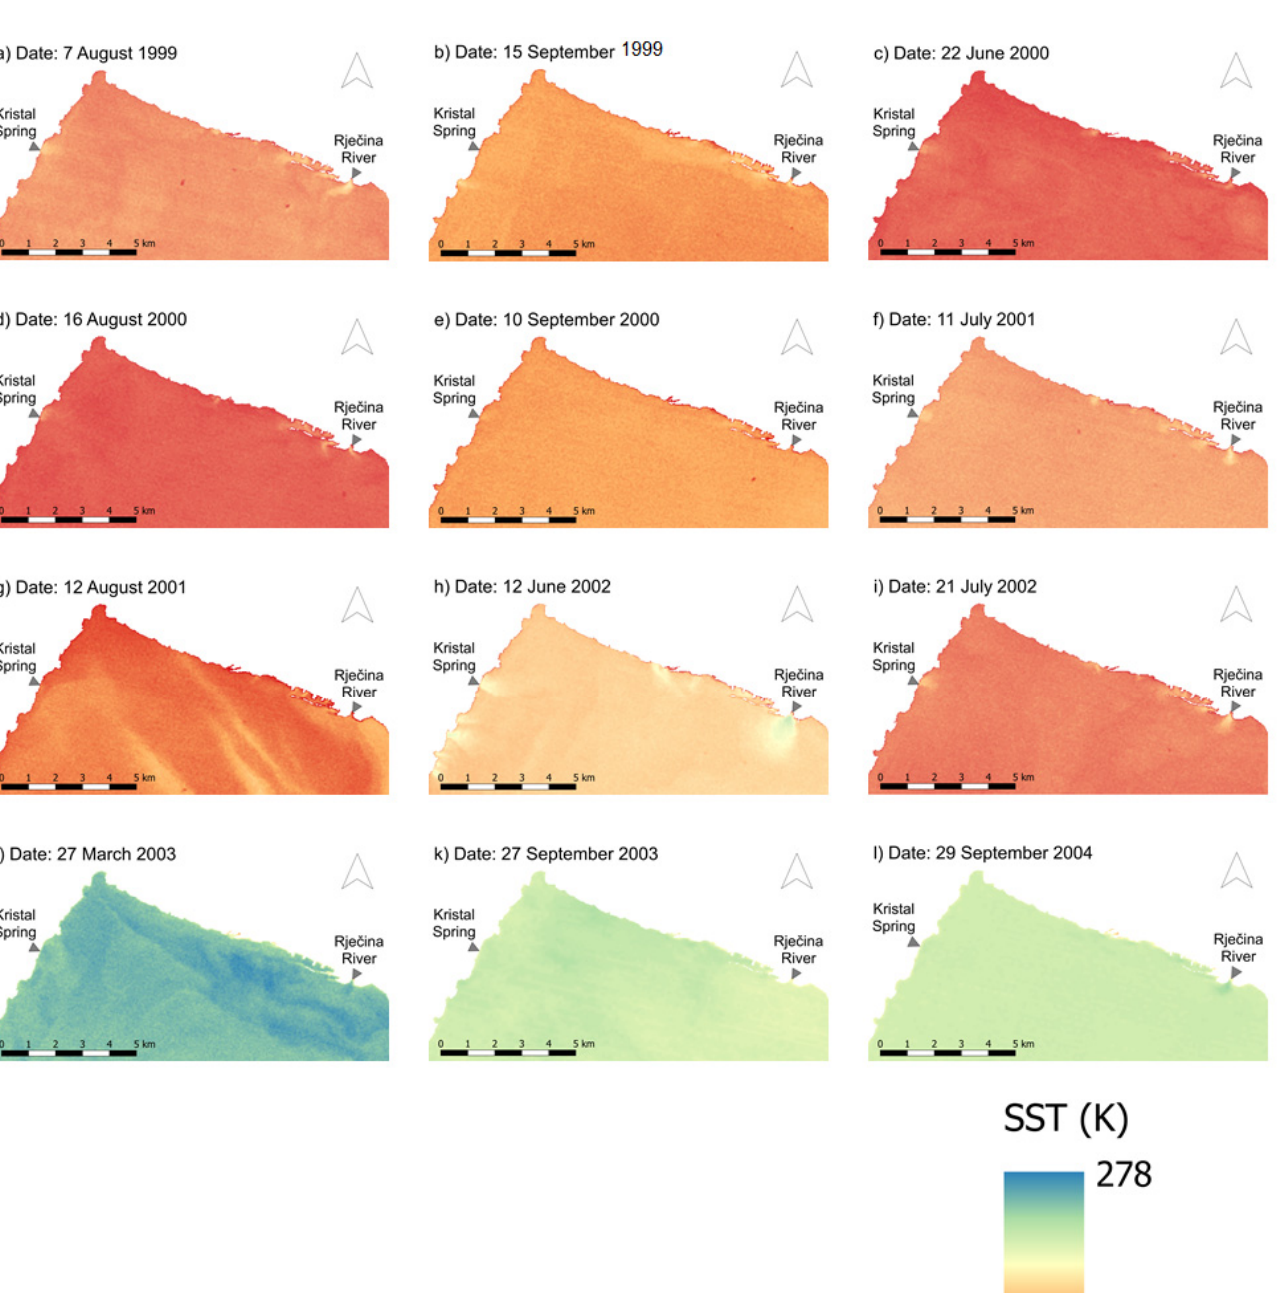
Figure 2. ( a – l ) Twelve sea surface temperature (SST) maps showing the thermal anomalies caused by the freshwater outflows over the period from 1999 to 2004.